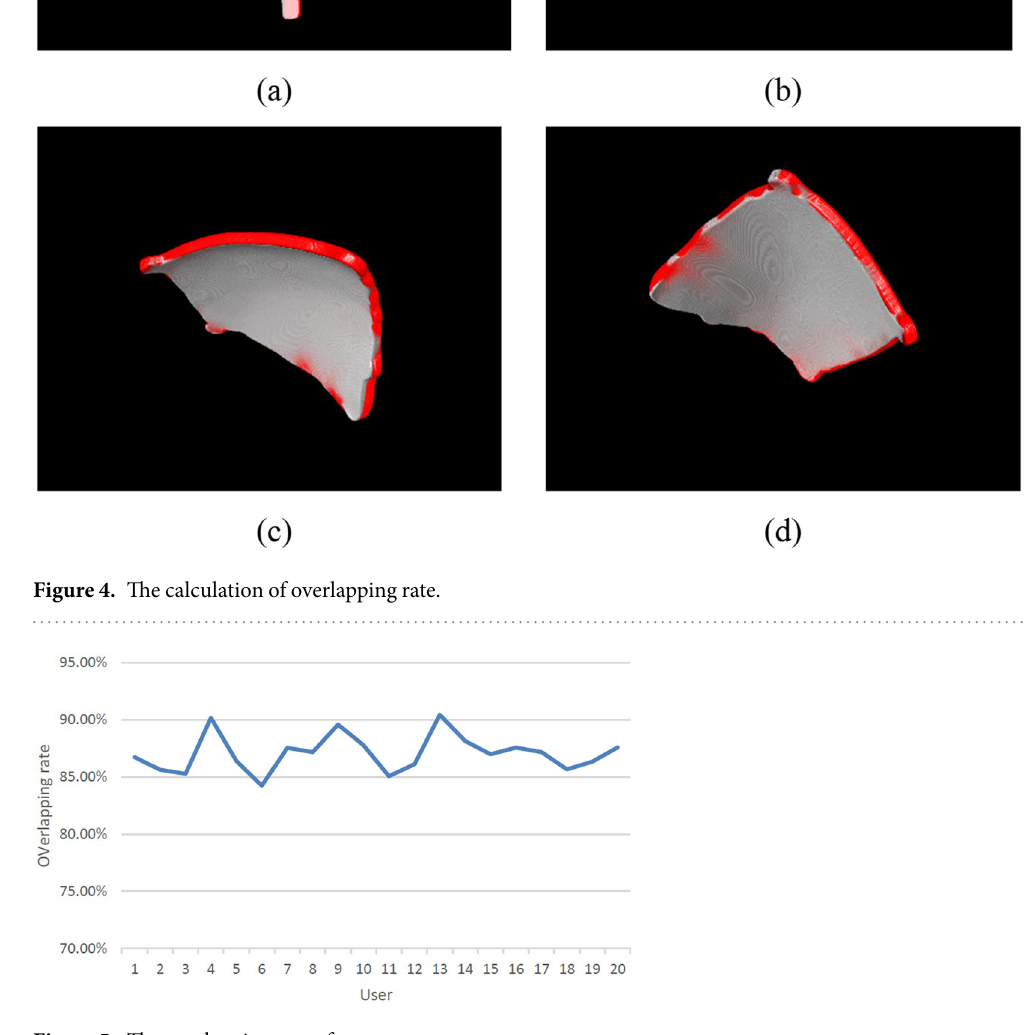
Figure 5. The overlapping rate of twenty